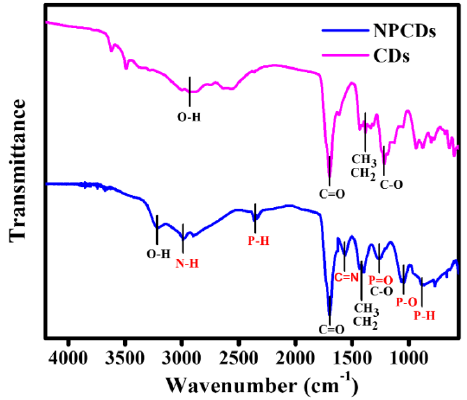
Figure 4. FTIR spectra of CDs and NPCDs.